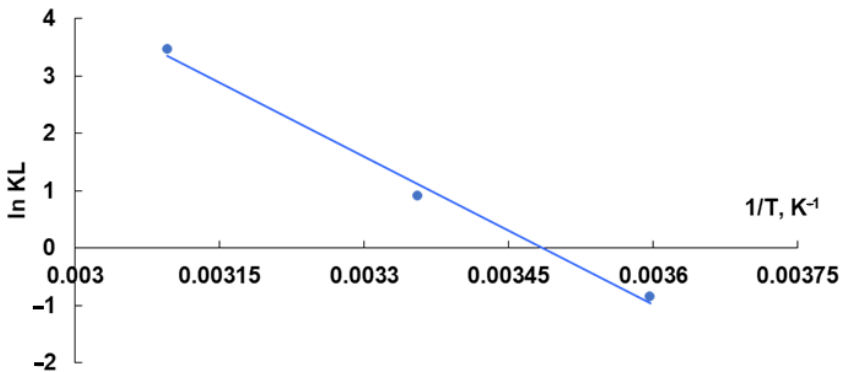
Figure 9. Graphical representation used to determine the ∆ H and ∆ S characteristic values of the biosorption process of Methylene Blue dye on OxC25 hydrogel as a biosorbent. Conditions: pH = 11, contact time = 24 h, amount of biosorbent = 0.4 g/L.